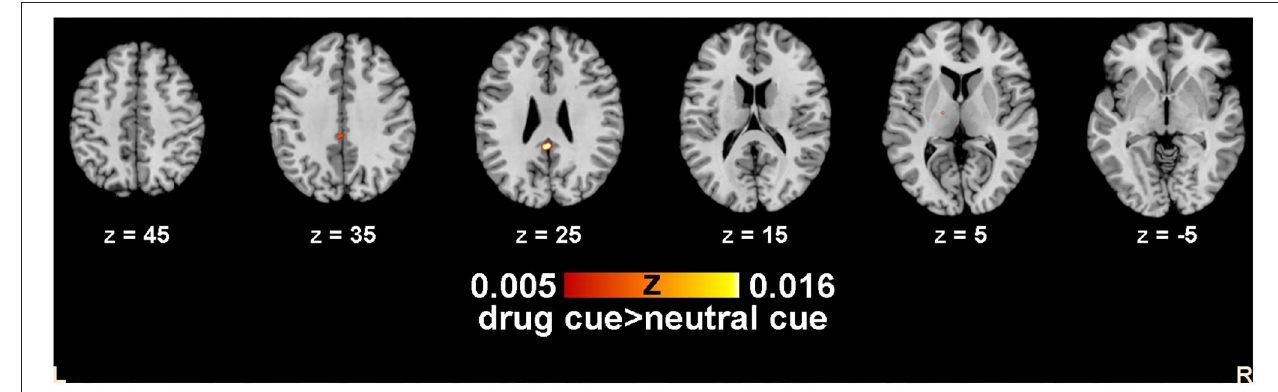
FIGURE 2 | Co-activated clusters about alcohol, nicotine, and illegal drugs. Slices taken at X = 0; Y = − 18.